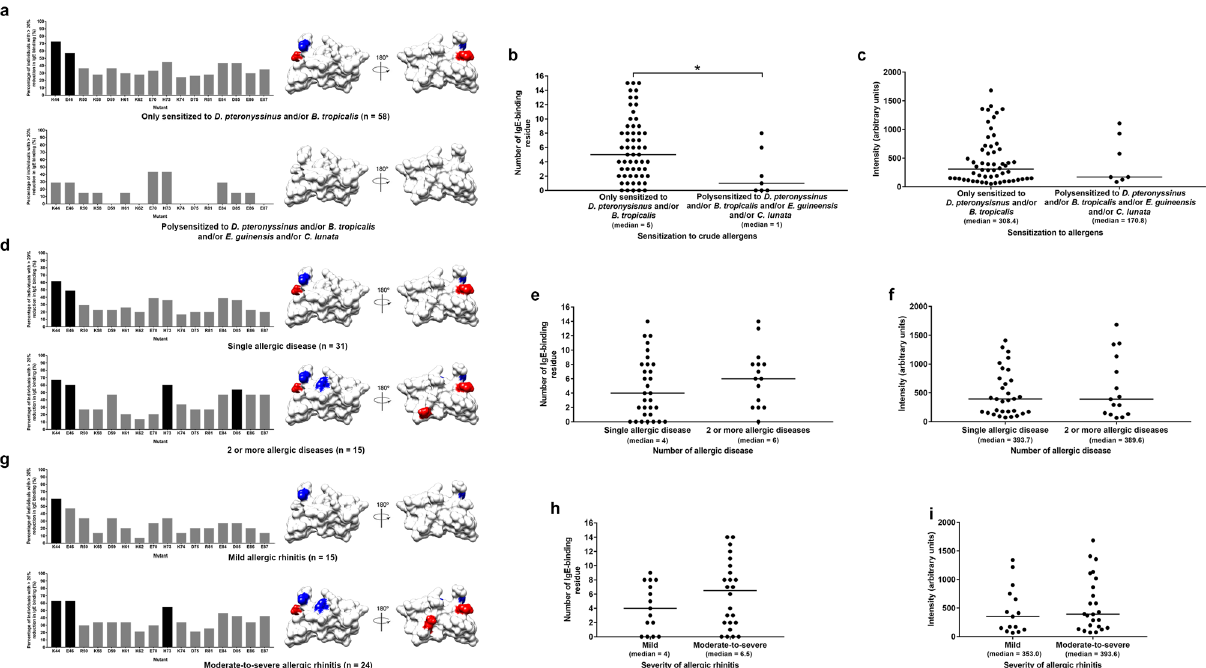
Figure 5. Analysis of major IgE-binding residues of rDer p 23 between allergic individuals with ( a ) different sensitization to crude allergen (sensitized to D. pteronyssinus and/or B. tropicalis vs polysensitized to D. pteronyssinus and/or B. tropicalis and/or E. guineensis and/or C. lunata ) (d ) allergic multimorbidity (single allergic disease vs 2 or more allergic diseases), and ( g ) severity of allergic rhinitis (mild vs moderate-to severe). Mutations that cause more than 20% reduction of the IgE binding in the individual sera are considered significant. Percentage of individuals showing > 20% reduction of IgE binding compared to wild type rDer p 23 was plotted for each mutant. Mutations that cause a significant reduction in the IgE binding in over 50% of individuals (the major IgE-binding residue) are highlighted in black (right panel) and their location on the rDer p 23 structure is mapped (left panel). Scatter plots showing ( b , e , h ) number of IgE-binding residues and ( c , f , i ) IgE-binding intensity for each comparison (median value are indicated). Blue: positively charged residues; Red: negatively charged residues. The electrostatic surface charge diagram was generated using program Chimera 37